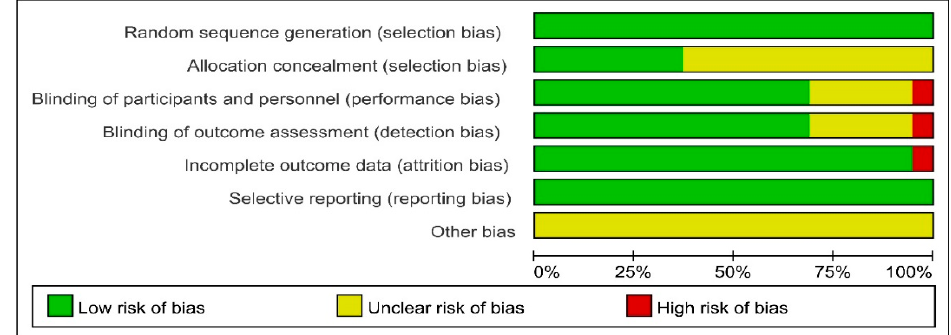
Figure 2. Résumé of results of risk of bias assessment. Figure 2. R é sum é of results of risk of bias